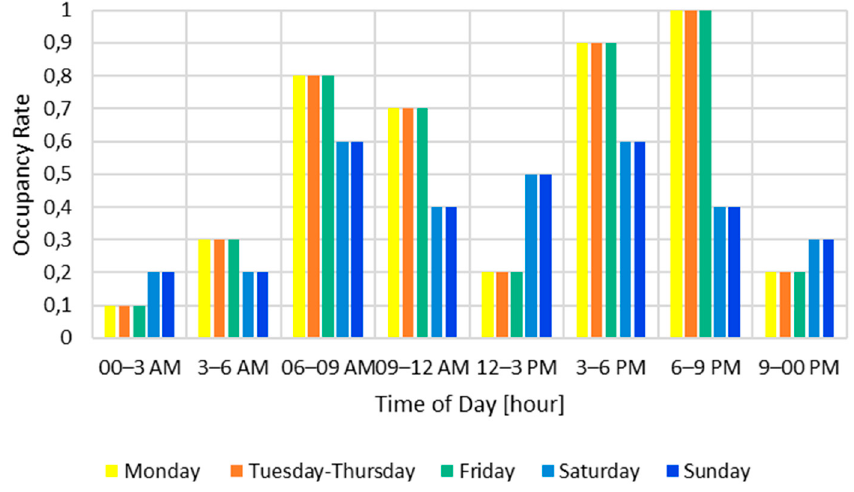
Figure 13. Occupancy rate in a typical working week.